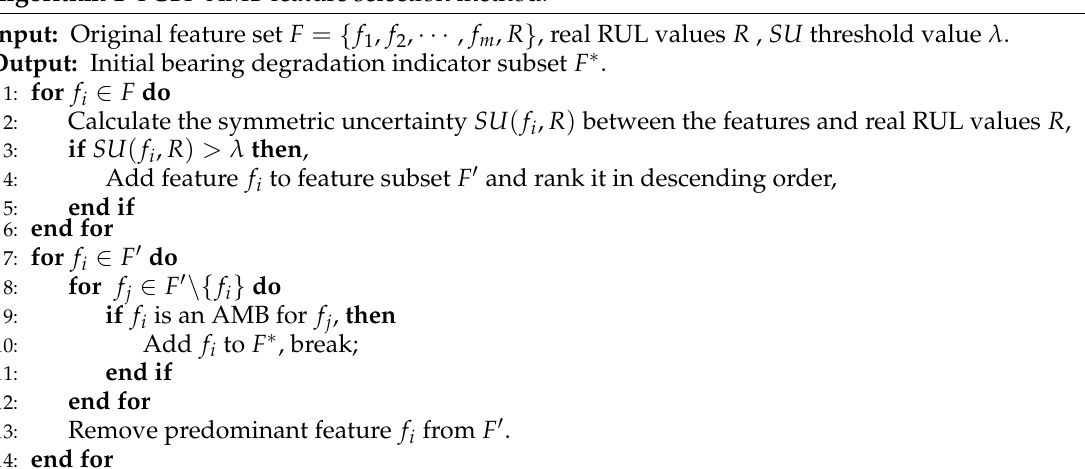
Algorithm 1 FCBF-AMB feature selection